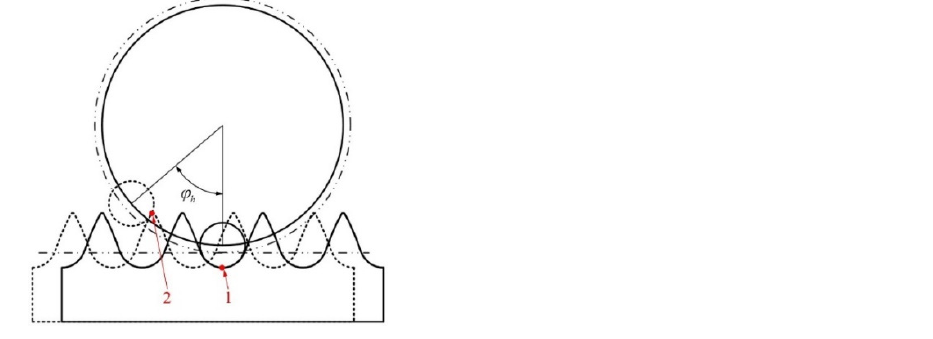
Figure 6. Schematic diagram of the meshing in and out points of the trochoid roller pinion rack. The calculation of the rotation angle of the roller pinion at the meshing point 2 also needs to be analysed from the formation principle of the trochoid profile. The meshing process of the roller pinion and the rack is actually the formation process of the trochoid rack tooth profile. Figure 7 shows the position of the roller pin when the roller pin is out of engagement. XOY is the coordinate system during meshing, which coincides with the X -axis in Figure 5. The difference is that the coordinate system is moving relative to the rack, but the coordinate value in the Y -axis direction is the same as the value when the tooth profile is formed. The value of Y -axis coordinate of the meshing out point is h + a .